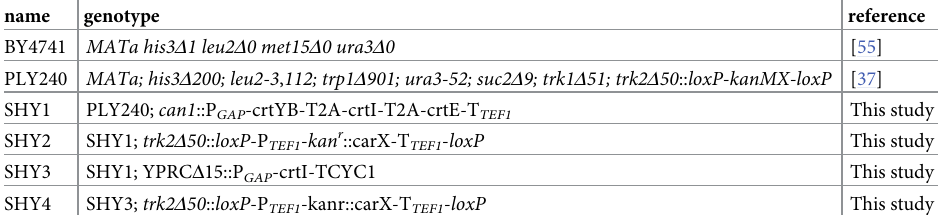
Table 2. Yeast cells used in this